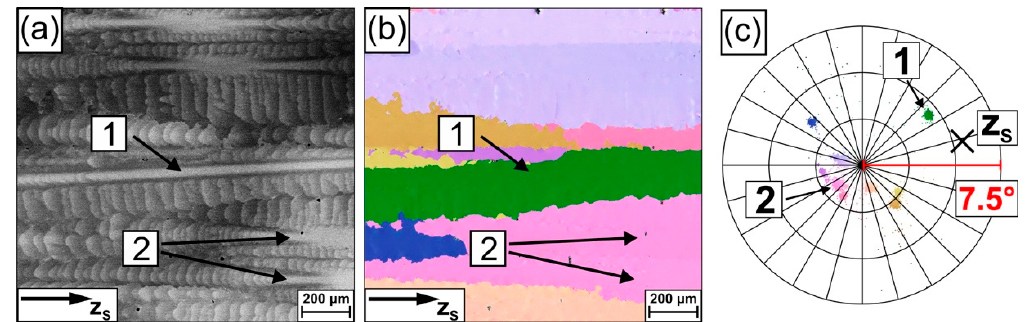
Figure 12. Correlation between dendrite growth directions and crystal orientations. ( a ) SEM back scatter electron (BSE) micrograph. ( b ) Corresponding RVB-EBSD map of the [001] direction; for color-coding, see next figure. ( c ) Pole figure with color-coding for the previous figure. The same dendrites are marked in each figure.